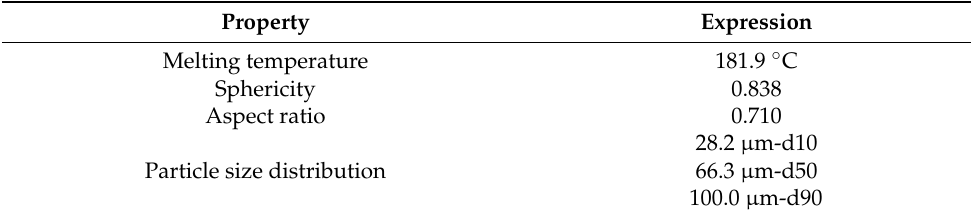
Table 2. Investigated properties of the used sinter material.